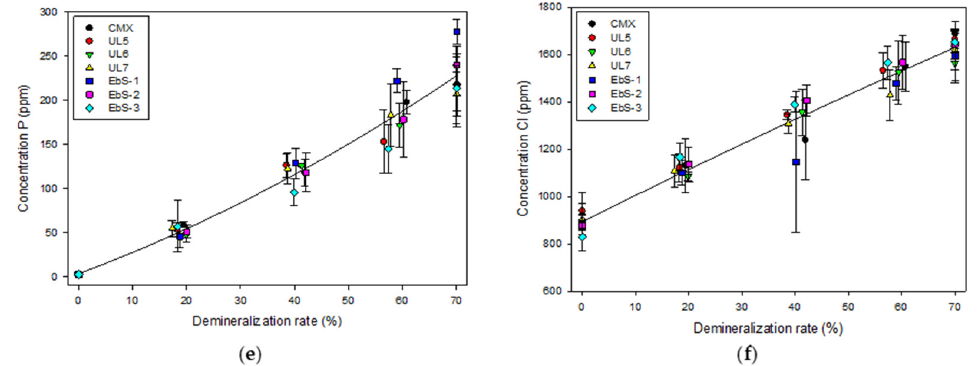
Figure 5. Concentration of ions in the concentrate compartment during electrodialysis as a function of the demineralization rate: ( a ) Calcium; ( b ) potassium; ( c ) magnesium; ( d ) sodium; ( e ) phosphorous; ( f ) chloride.